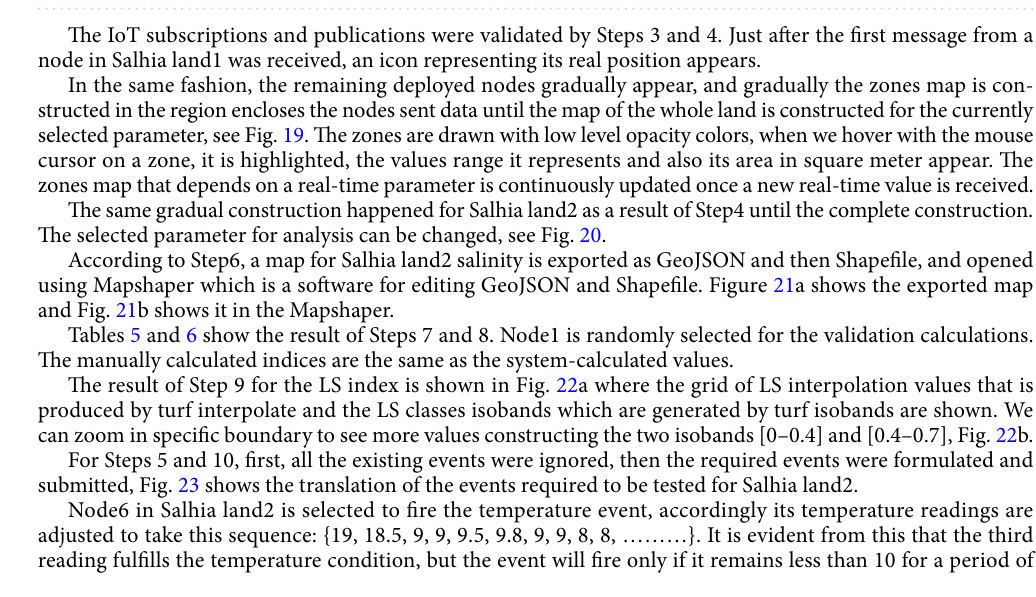
Figure 20. The complete MZ map for the two lands for two parameters, ( a ) the ESP maps, ( b ) LS classes